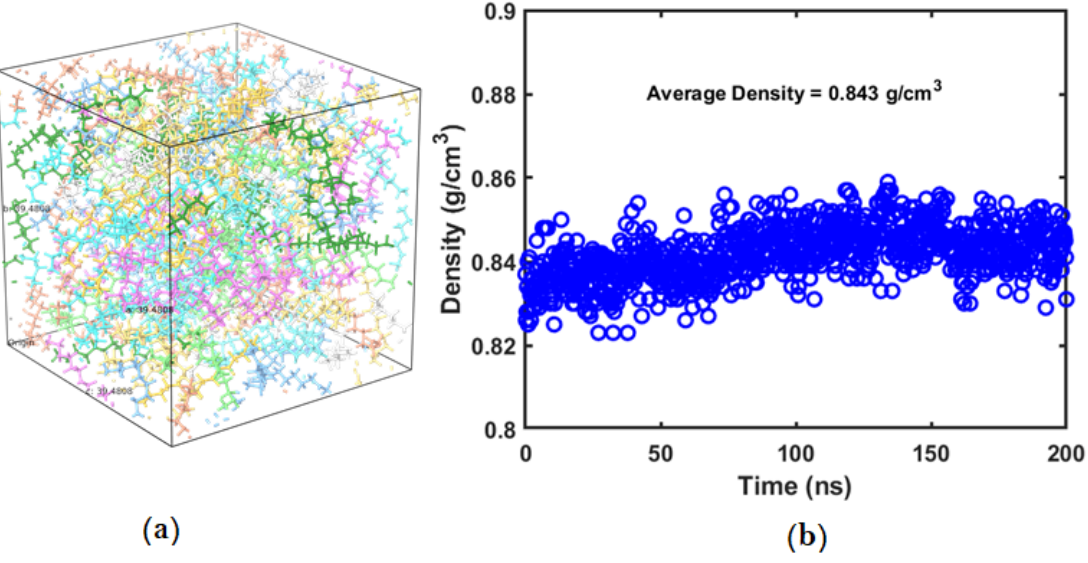
Figure 1. ( a ) Equilibrated polyethylene system with 10 chains (each chain represented with a specific color). ( b ) Density vs. equilibration time profile for polyethylene system.